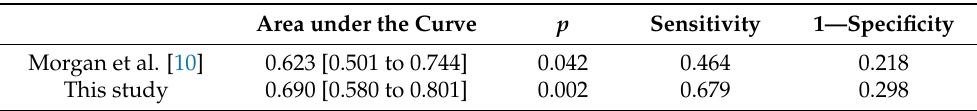
Table 3. Diagnostic efficacy of axial length calculation. The mean area under the curve and its range is presented.